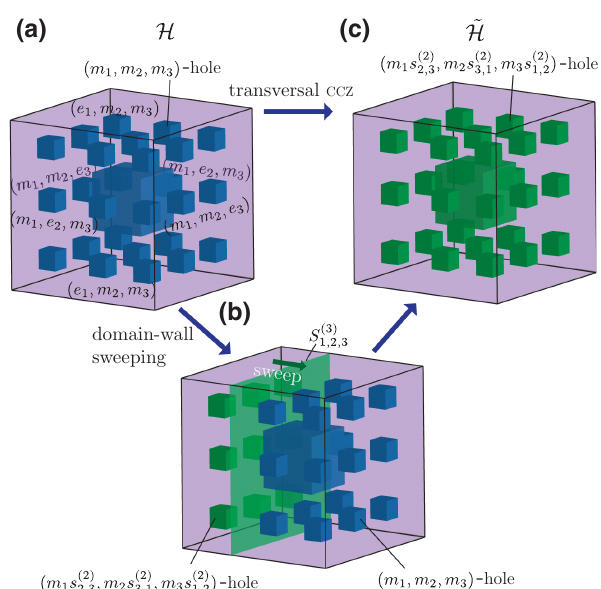
FIG. 30. The application of a transversal CCZ gate on a stack of three fractal surface codes effectively sweeps the s ( 3 ) domain wall across the system and attaches the wall onto all the ( m 1 , m 2 , m 3 ) -holes (blue) in the bulk, producing new ( 2 ) ) -boundaries (green) on these holes, which ( m , m 2 s ( 2 ) , m 3 s ( 2 ) 1 s 2,3 3,1 1,2 couple the three codes together as previously illustrated in Fig. 28. a = 1, 2, 3 labels the a th copy of the 3D fractal